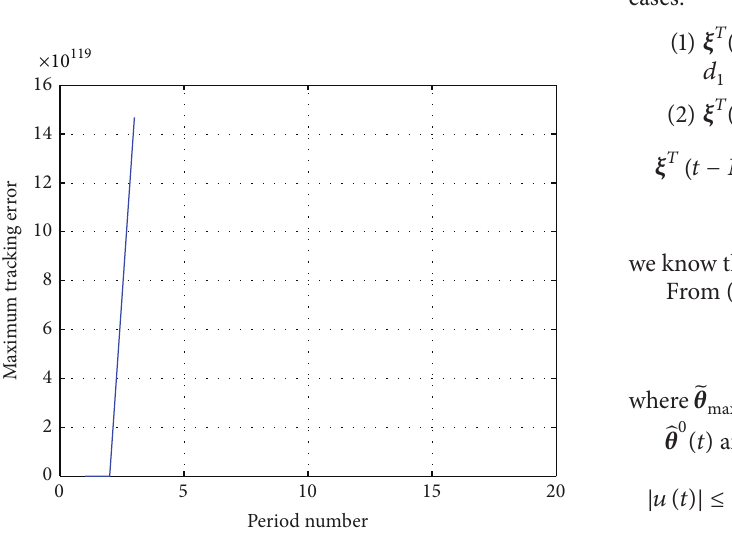
Figure 3: The convergence property of tracking error with period.